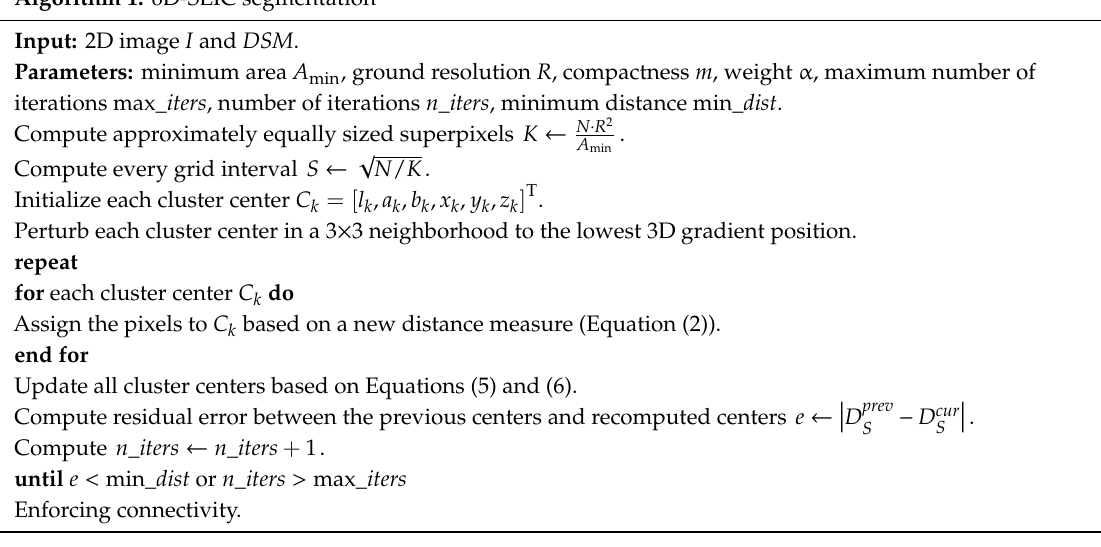
Algorithm 1: 6D-SLIC